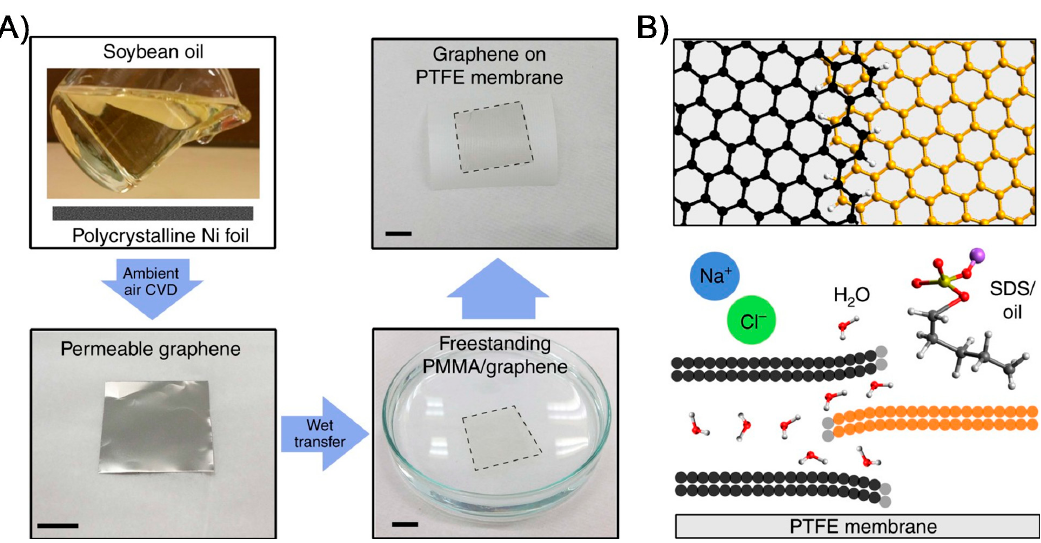
Figure 4. Synthesis of graphene film for water desalination membranes. The schematic ( A ) depicts the formation of permeable graphene using polycrystalline Ni substrate through ambient-air CVD process using soybean oil as a renewable source. The synthesized permeable graphene film was transferred to commercial PTFE-based MD membrane for water desalination testing. ( B ) The proposed mechanism of water purification and desalination is enabled by unique graphene features such as overlapping of graphene domains and grain boundaries as an advantageous feature in forming antifouling, long-term flux stable MD membrane (reproduced from [85] with permission from the springer nature).